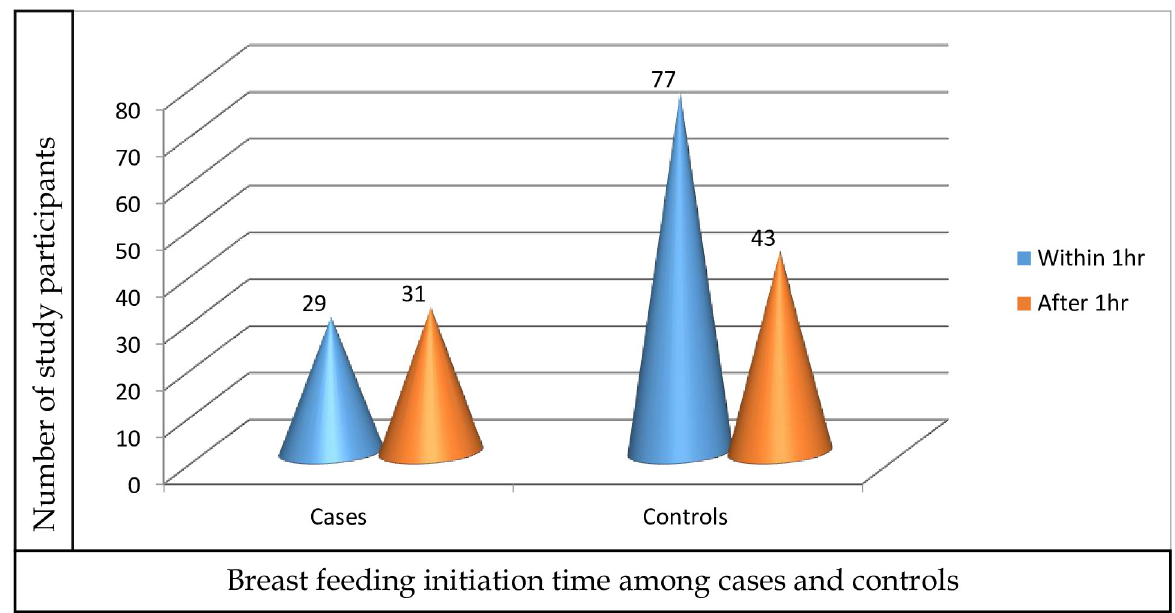
Fig 1. Breastfeeding initiation time among the study participants admitted to NICU of Arbaminch general hospital, Gamo zone,